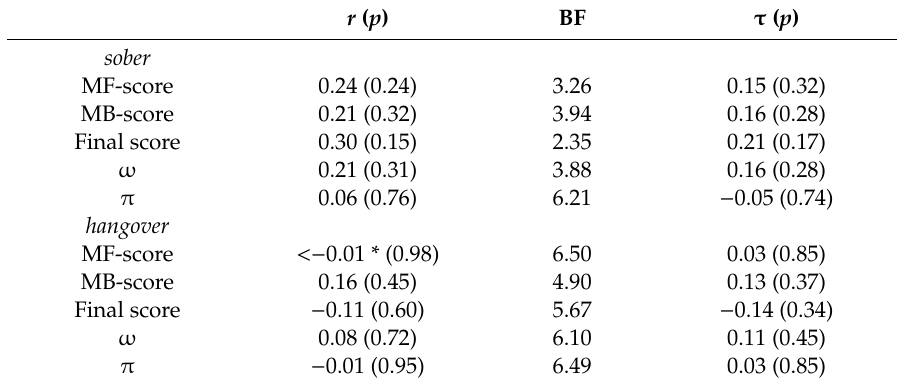
Table 4. Correlation between AUDIT and two-step task performance in the sober and hangover session. r ( p ) BF τ ( p ) sober MF-score 0.24